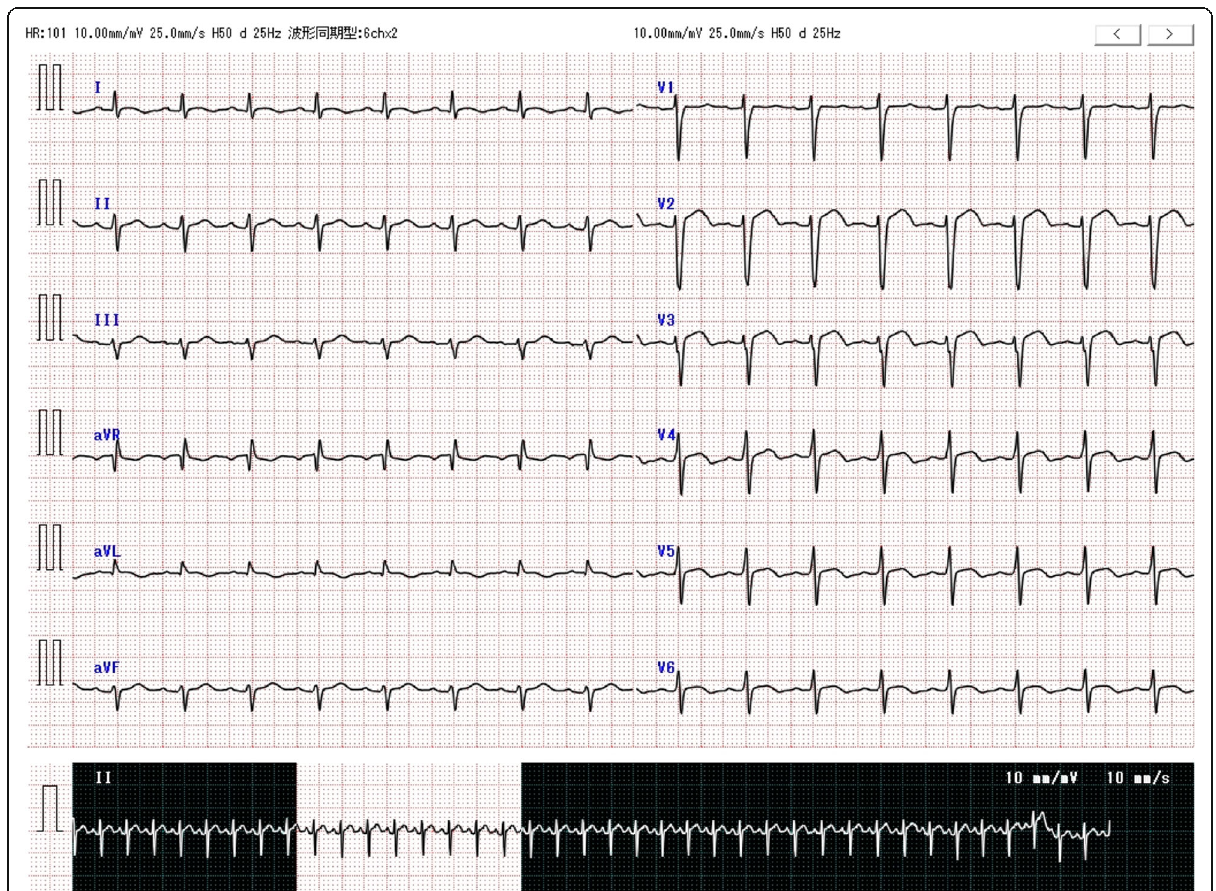
Fig. 2 Pre-operative electrocardiogram (ECG) depicting the non-specific ST elevation and left bundle branch block